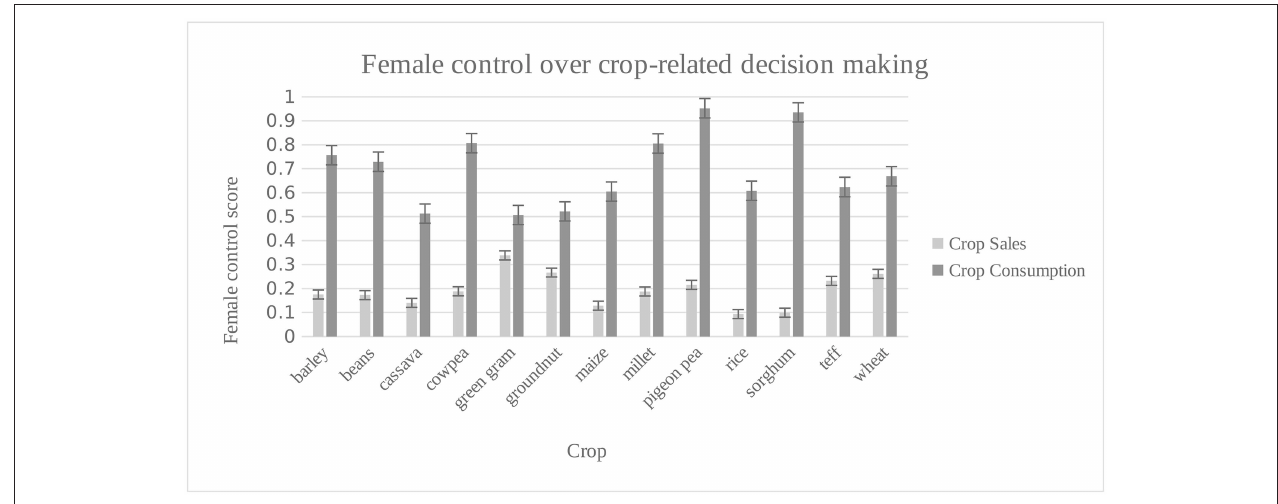
FIGURE 2 | Female control over crop-related decision making across all systems and gender-respondent-household typologies.